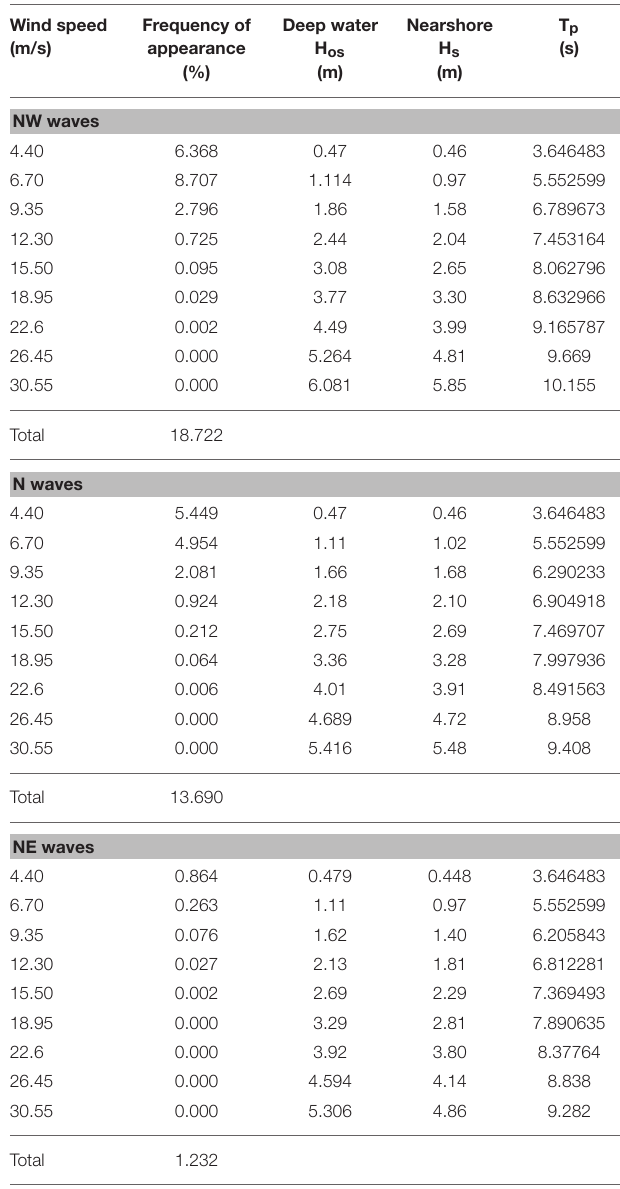
TABLE 1 | Significant wave height, peak period, and frequency of appearance offshore the Heraklion port and in front of the